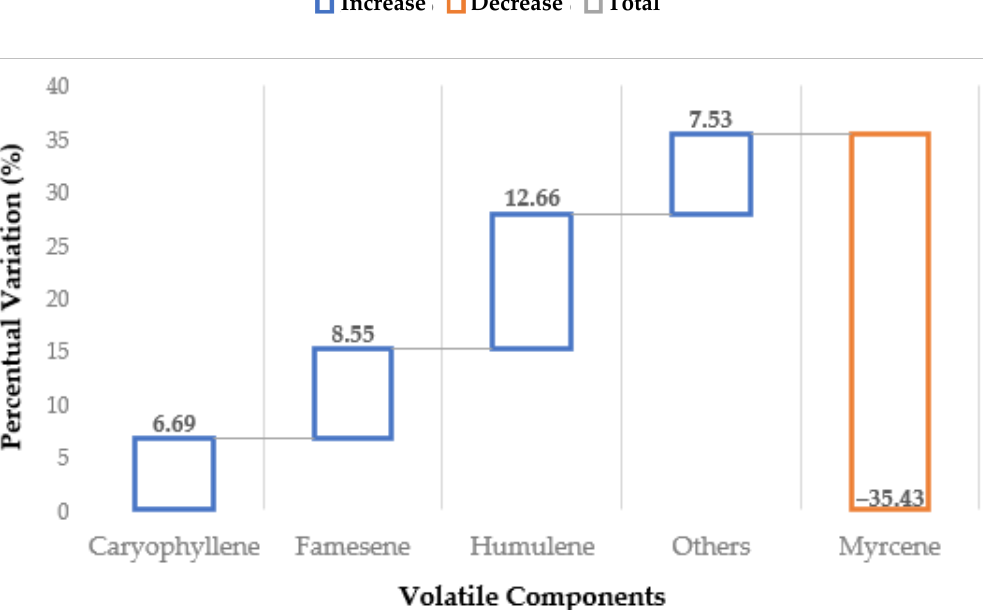
Figure 11. Waterfall chart of main-terpene percentage variation, according to normal and extended MAHD, performed with ETHOS XL.